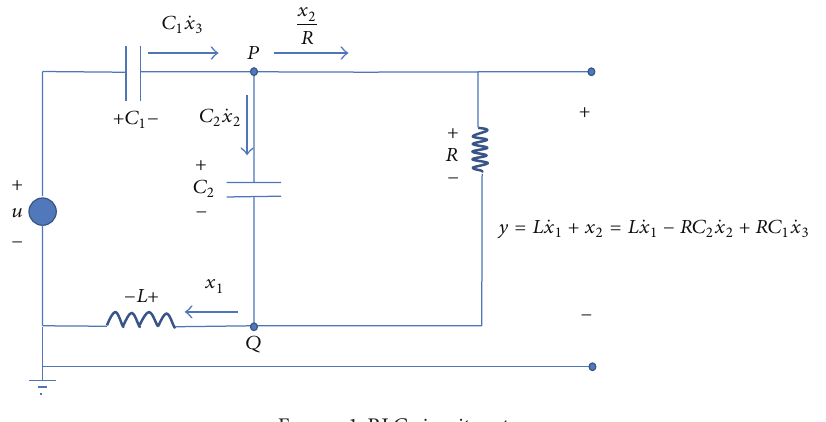
Figure 1: RLC circuit